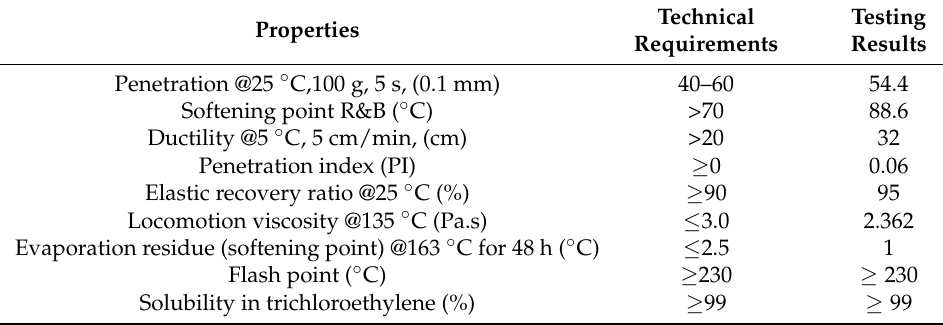
Table 2. Properties of the PG76-22-modified asphalt.